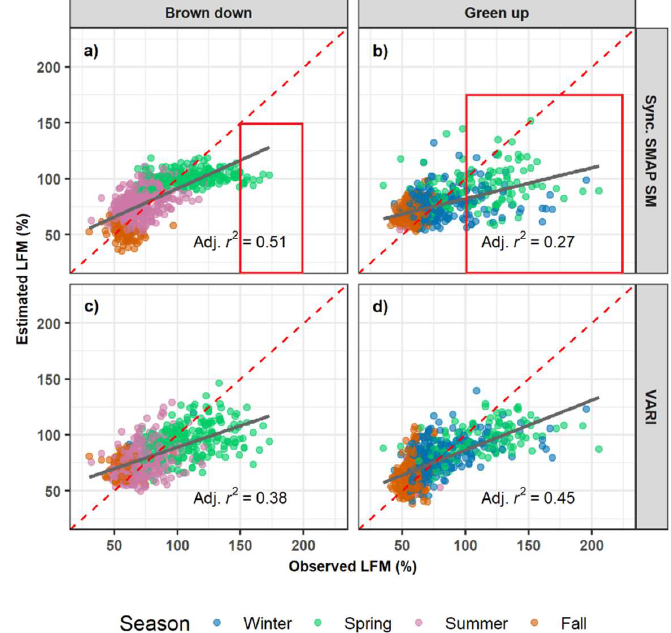
Figure 7. Observed LFM and estimated LFM using the synchronized SMAP SM and cumulative GDD ( a , b ). The brown-down and green-up periods were modeled separately. Outcomes from the VARI-only model were used for comparison ( c , d ). Data were colored by seasons, using blue for winter, green for spring, pink for summer, and orange for fall.